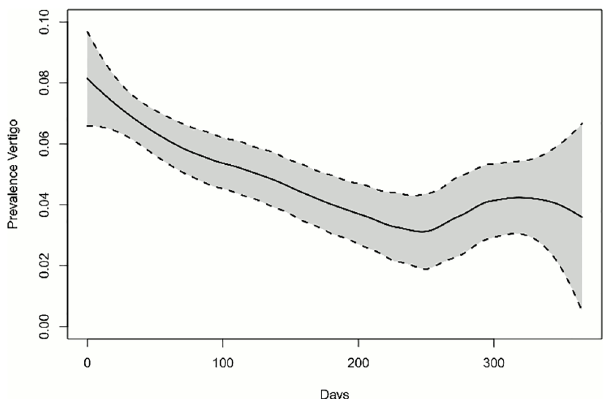
Fig 3. Trend of prevalence of vertigo. The prevalence of MD episodes is illustrated over the first 365 days after inclusion in the study. The black line corresponds to the loess smoother with k = 0.75. The dotted line displays the pointwise 95%-confidence intervals of the smoother. We observed a decrease in MD episode prevalence over the first 240 days and an increase